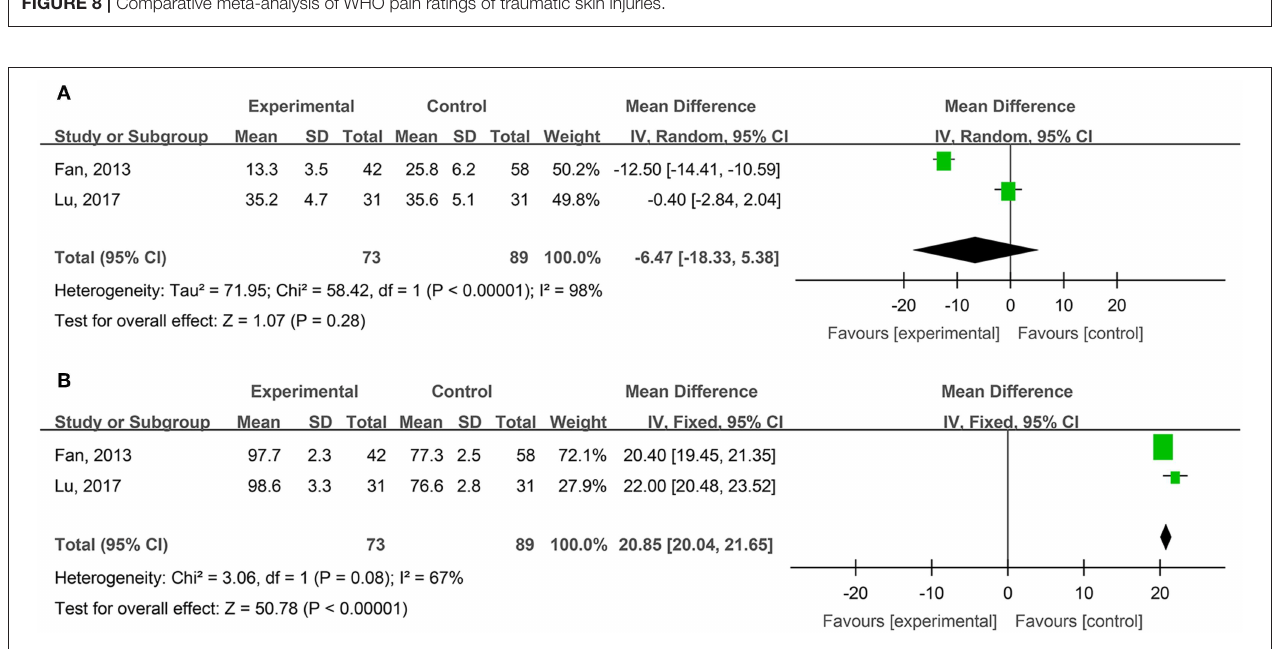
FIGURE 9 | Comparative meta-analysis of healing times (A) and cure rates (B) of surgical wounds.